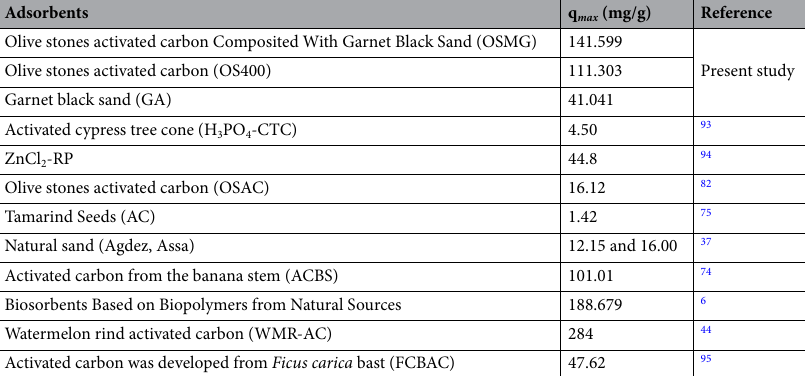
Adsorbents q max (mg/g)